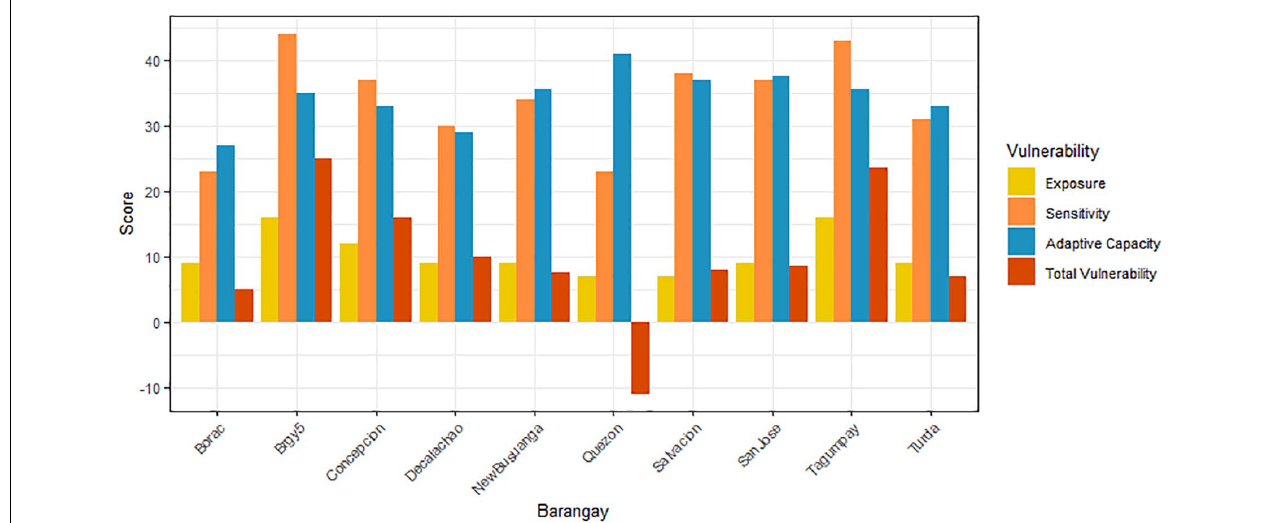
FIGURE 4 | Bar plots showing the sum of all scores for Exposure (E), Sensitivity (S) and Adaptive Capacity (AC) criteria, and the total Vulnerability score (V = E + S-AC) in 10 barangays. The 10 barangays include in the Municipality of Busuanga: Quezon, Concepcion, Salvacion, New Busuanga, in the Municipality of Coron: San Jose, Decalachao, Turda, Borac, Tagumpay, Barangay